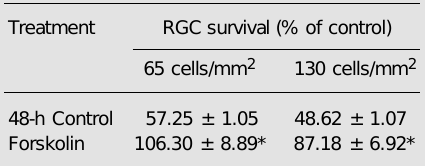
Figure 1. Dose-dependent effect of forskolin on retinal ganglion cell (RGC) survival after 48 h in culture. Cultures were treated with forskolin (5, 10, 25 and 50 µM). CT = control, F = forskolin. The number of RGCs counted in 4-h cultures was 21,140 cells. Data are reported as the per- centage of RGC survival com- pared with 4-h control cultures (100%) and represent the mean ± SEM of two different experi- ments, each performed with at least three different Petri dishes (N = 3-4). *P<0.001 compared to the 48-h control (Newman- Keuls test).